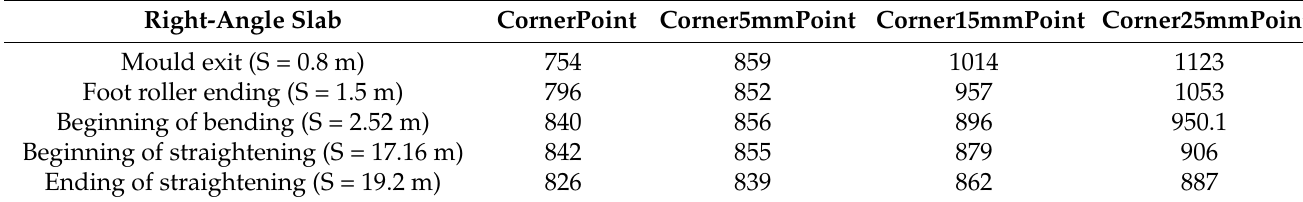
Figure 11. Temperature distribution under weak cooling in foot roller zone of the right-angle slab. ( a ) The whole process of slab solidification, ( b ) enlarged view of mould and bending section. As shown in Tables 4 and 5, the temperature at the beginning of straightening for the CornerPoint and Corner5mmPoint are 834 ◦ C and 842 ◦ C, respectively. Both are kept above 797 ◦ C for Ar 3 of S355 steel, which could effectively prevent the occurrence of ferrite films during the straightening process. However, the temperatures are still in the embrittlement zone. Therefore, the straightening cracks cannot be avoided for the right-angle slab with an intensive cooling or a weak cooling. Table 5. Temperature of right-angle slab under weak cooling (°C).